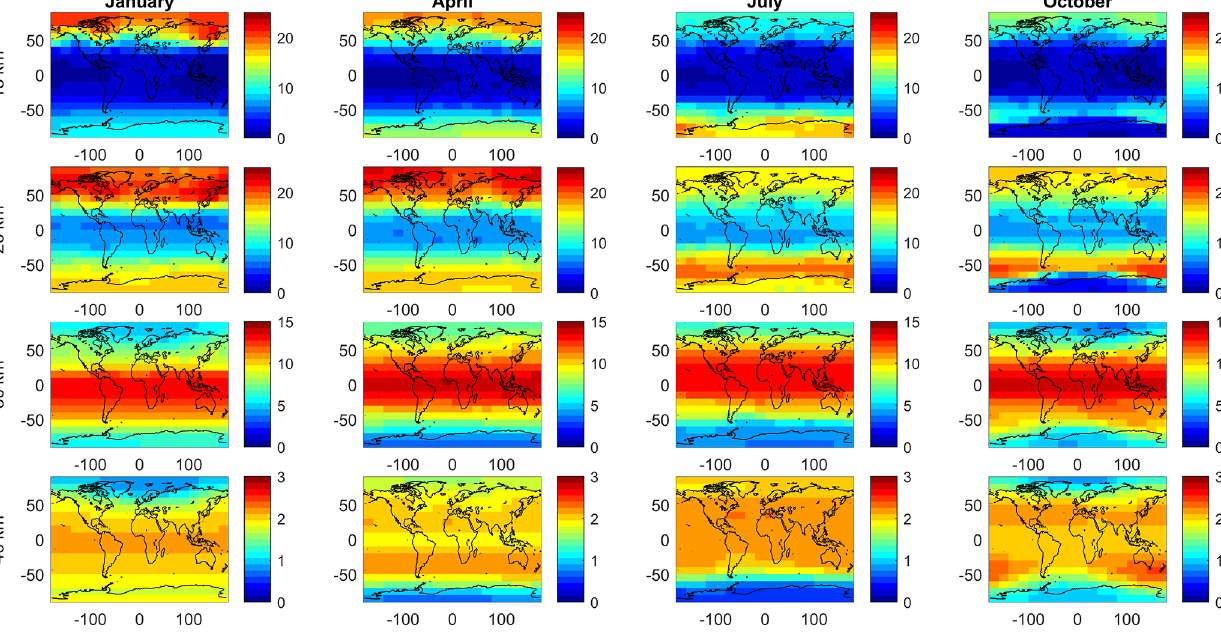
Figure 9. Climatological ozone distributions (in DUkm − 1 ) for January, April, July and October for selected altitude levels (15, 20, 30 and